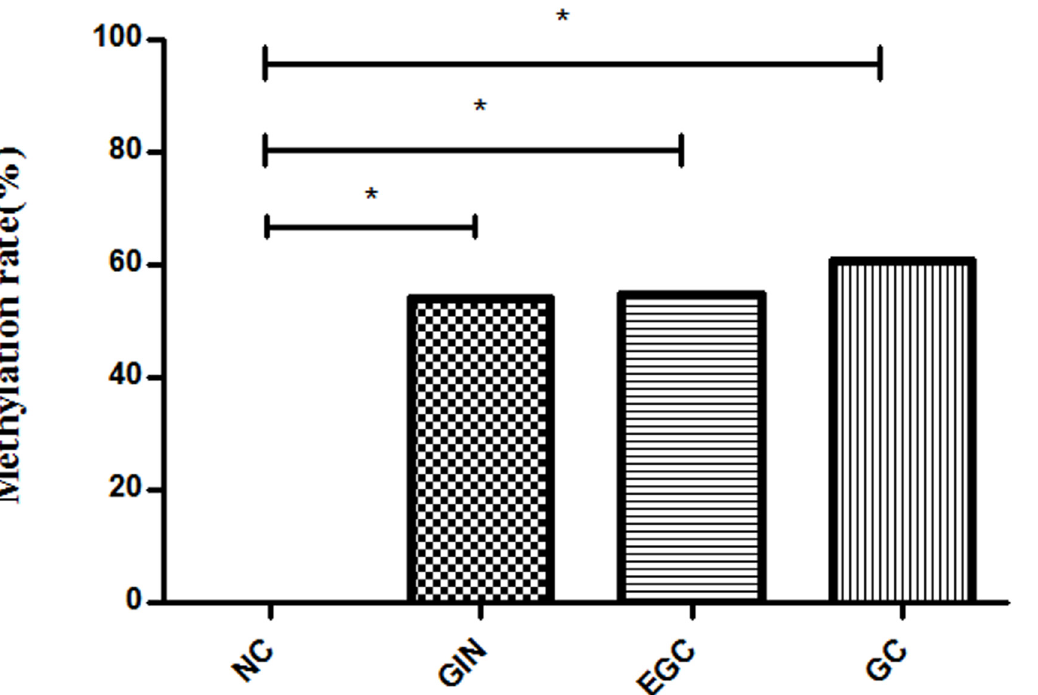
Fig 1. Percentage of Zic1 promoter methylation in the gastric cancer (GC), gastric intraepithelial neoplasia (GIN), early gastric cancer (ECG) and normal control (NC) groups. The percentages of Zic1 promoter methylation were 60.6% (63/104) in the GC, 54.0% (27/50) in the GIN, 54.8% (17/31) in the EGC and 0.0% (0/20) in the NC groups ( * : p < 0.001).